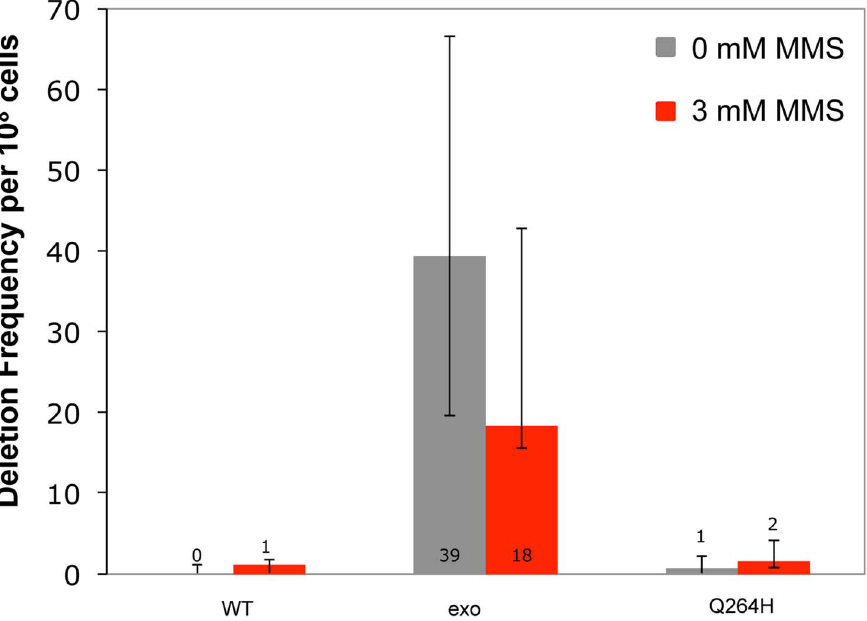
Figure 5. Methyl methanesulfonate exposure has no significant effect on deletion mutations between 21mer repeats. Median frequency ( 6 95% CI) of deletions between 96-mer direct repeats per 10 8 Arg + cells of heteroallelic strains containing a centromeric plasmid encoding MIP1 or mip1 with an exonuclease-disrupting mutation or a mutation encoding the Q264H variant in the presence (3 mM) or absence (0 mM) of methyl methanesulfonate. Mutant frequencies were determined from at least 20 different independent cultures. CI, confidence interval; MMS, methyl methanesulfonate.